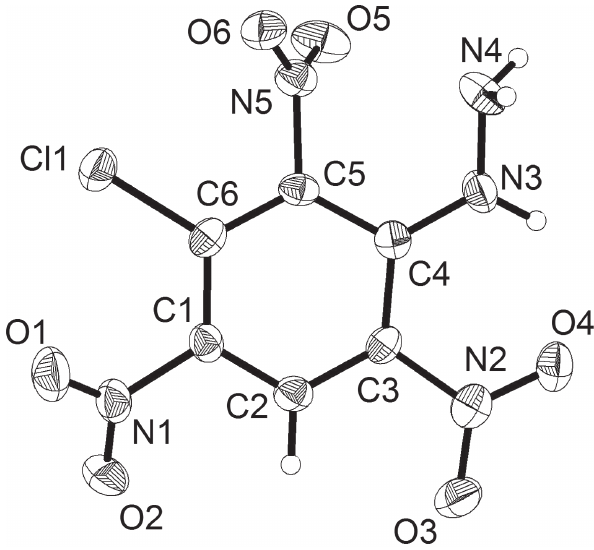
Table 1: Data collection and handling.